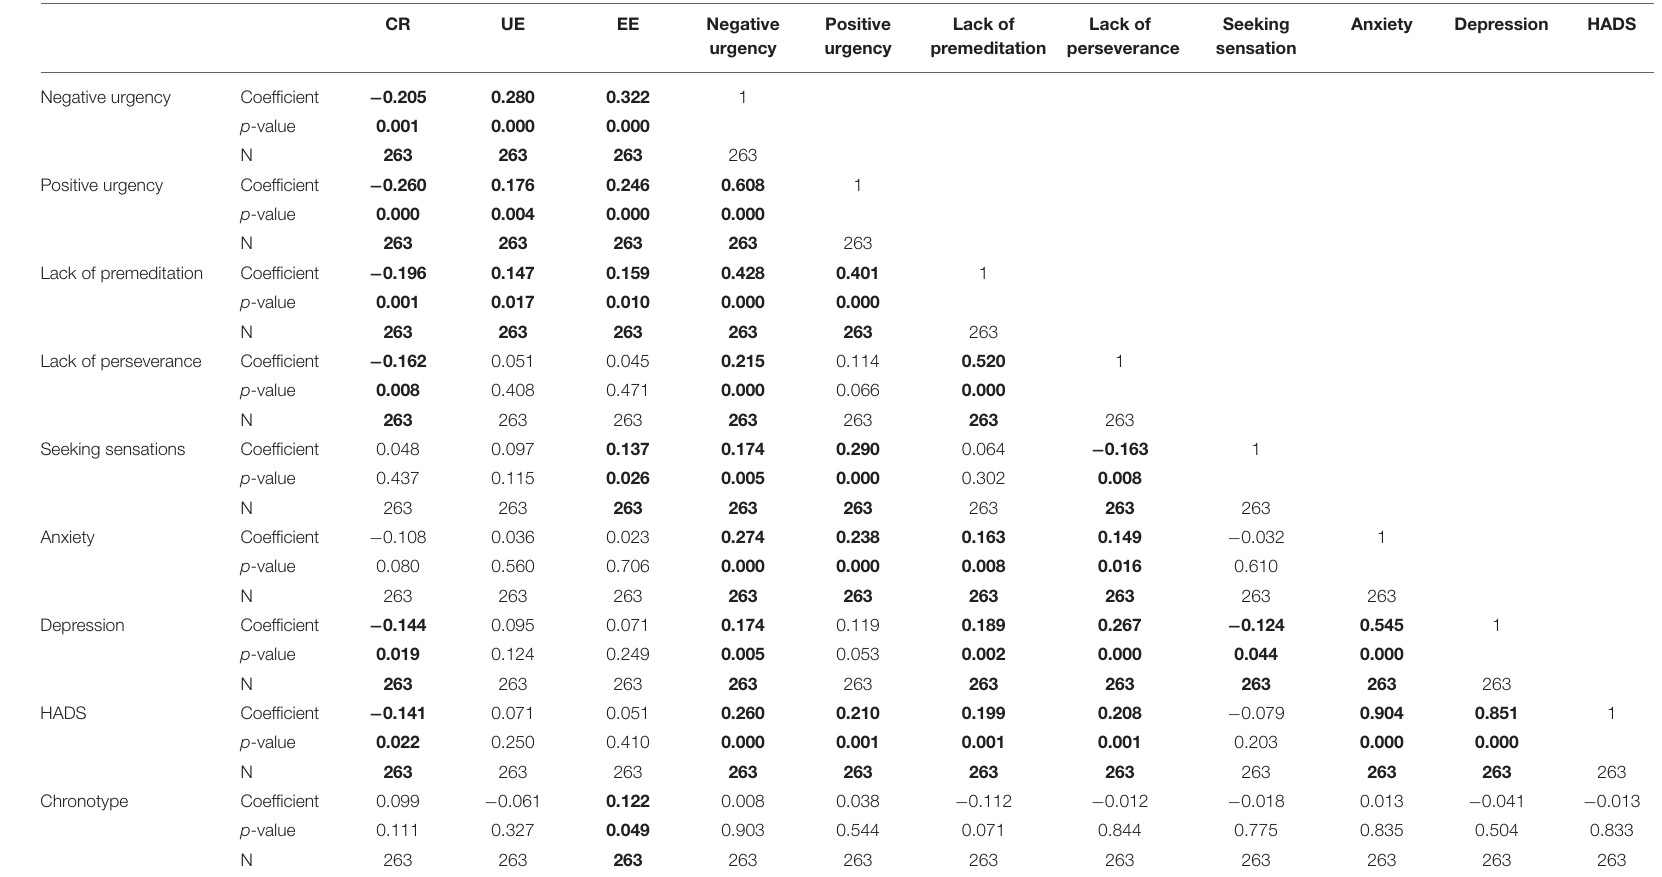
TABLE 7 | Correlations observed between the three aspects of eating habits and impulsivity, chronotype, anxiety, and depression among female participants.